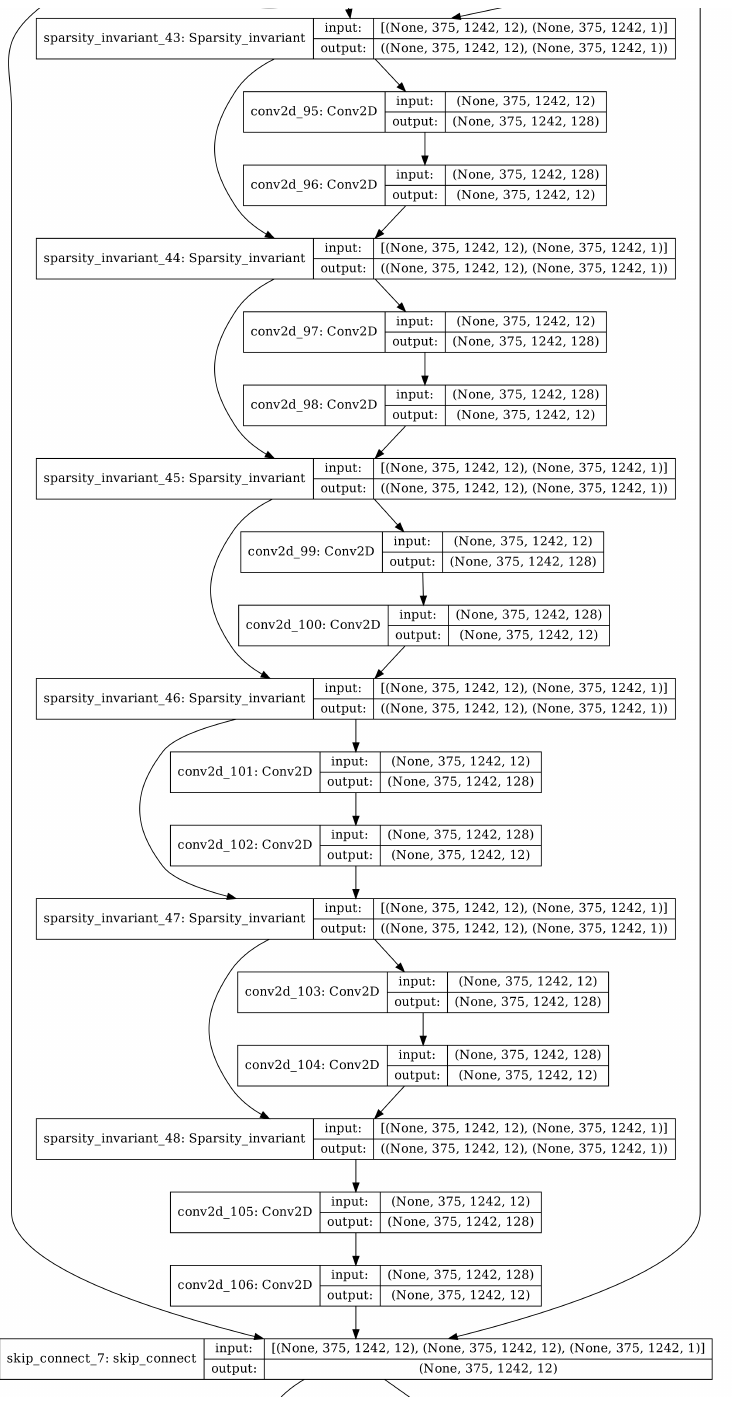
Figure 1. Schematic representation of a residual block containing 3